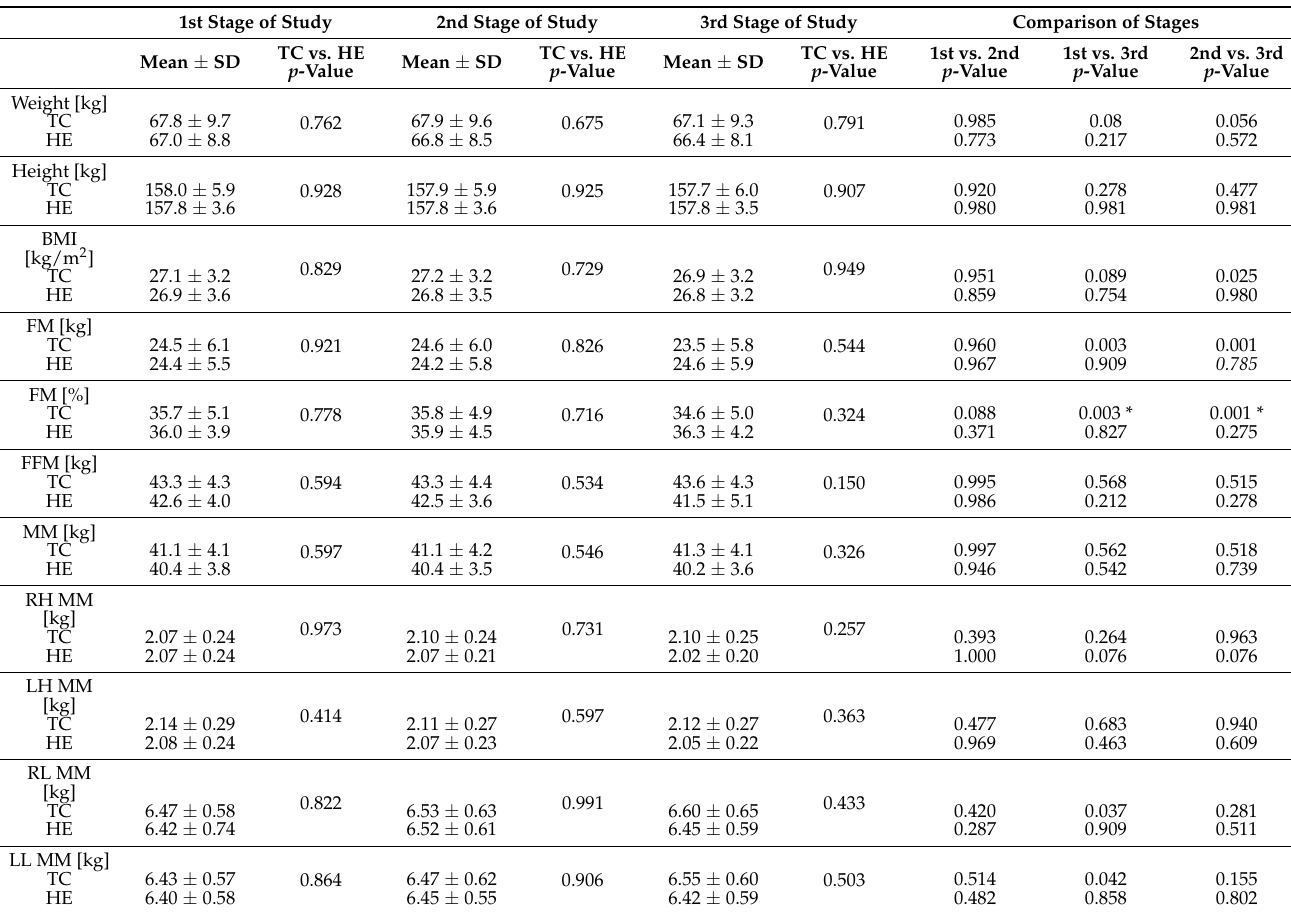
Table 3. Changes in body mass and body